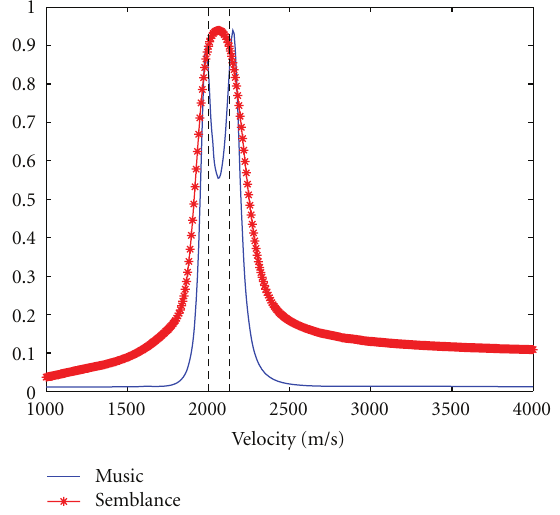
Figure 5: Spectrum of parameter C using both MUSIC and semblance (point di ff ractor and a dipping reflector β = 20 0 ). The black dotted lines show the correct location of the parameters C di ff and C dip . We see that only MUSIC was able to resolve the two parameters.